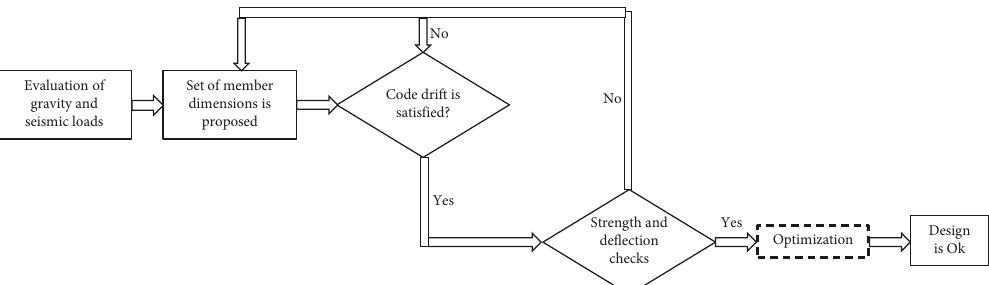
Figure 1: Typical design process of steel moment resisting frames. The dotted box represents the eigenfrequency optimization step proposed in this article.